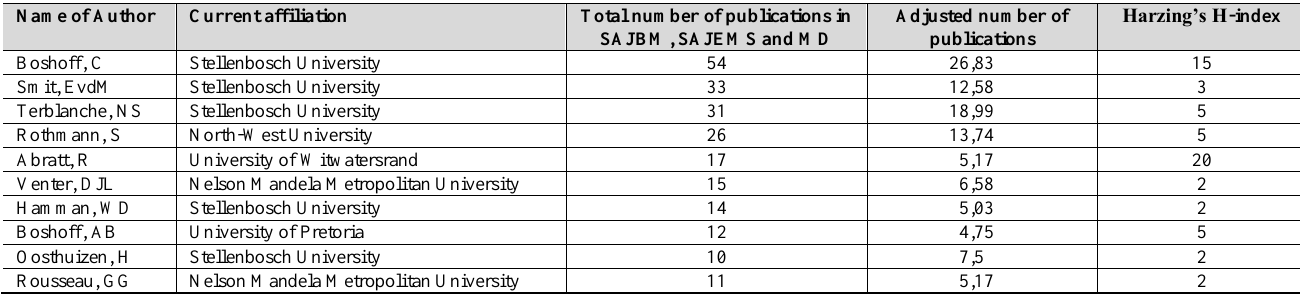
Table 3: Most prolific and most published